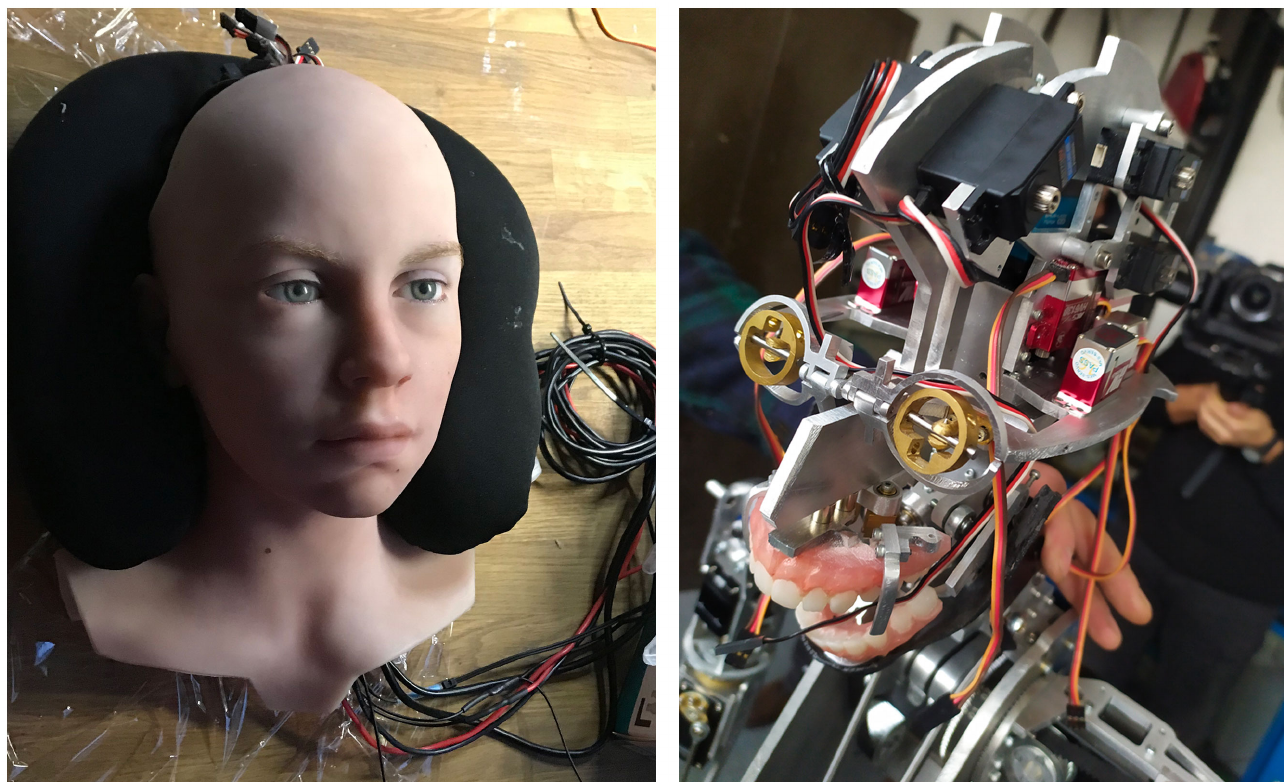
Figure 5. A detail of Abel’s head. On the left the head is covered with bioinspired skin-like material; on the right the internal mechatronics exposed, designed to perform facial expressions, gaze behavior, and lip-sync